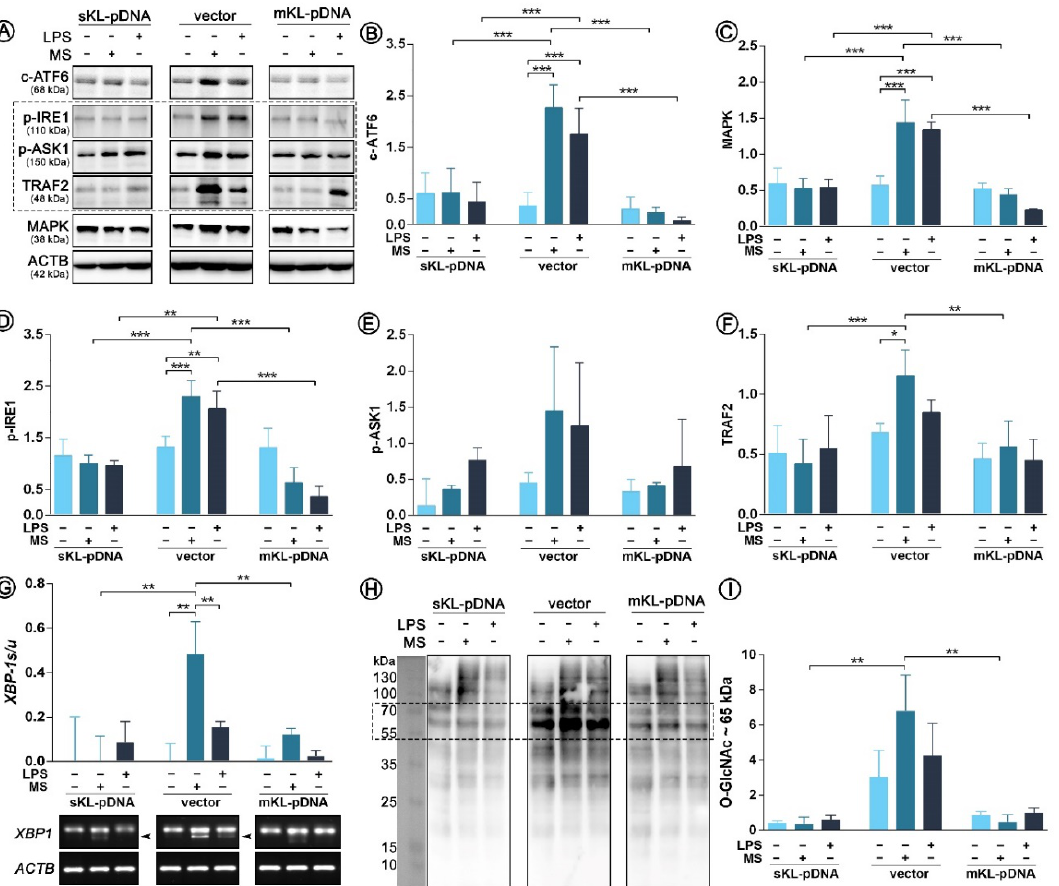
Figure 4. Expression of factors involved in ER stress response. Klotho expression was upregulated with pDNA, cells were treated for 72 h with monensin sodium or 168 h with LPS and expression of proteins involved in ATF6- and IRE1-mediated pathways was evaluated with Western Blot method ( A ), i.e.,: c-ATF6 ( B ), MAPK ( C ), p-IRE1 ( D ), p-ASK1 ( E ), and TRAF2 ( F ). XBP-1 splicing was evaluated by RT-PCR ( G ) and O-GlcNAc levels by WB ( H – I ). The bands were quantified and normalized to their corresponding β -actin bands. Bars indicate SD, n = 3, *** p < 0.001, ** p < 0.01, * p < 0.05, no indication – no statistical significance (one-way ANOVA and Dunnett’s a posteriori test).